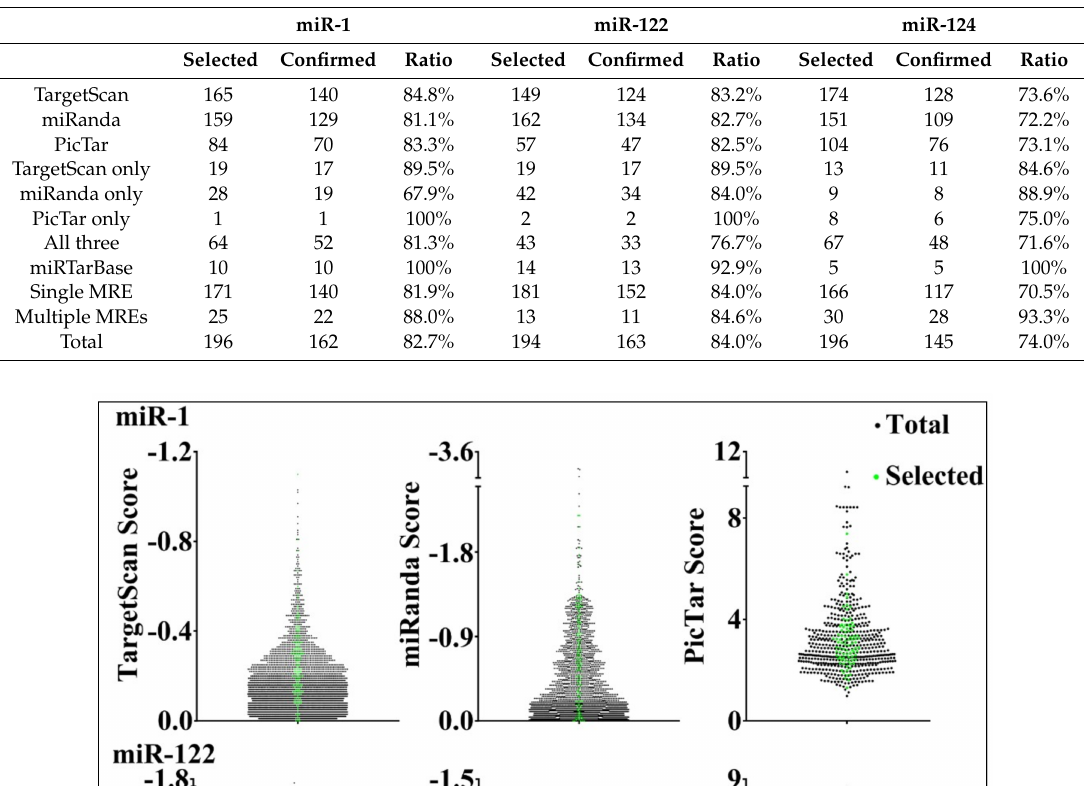
Table 1. Summaries of miRNA target confirmation results.